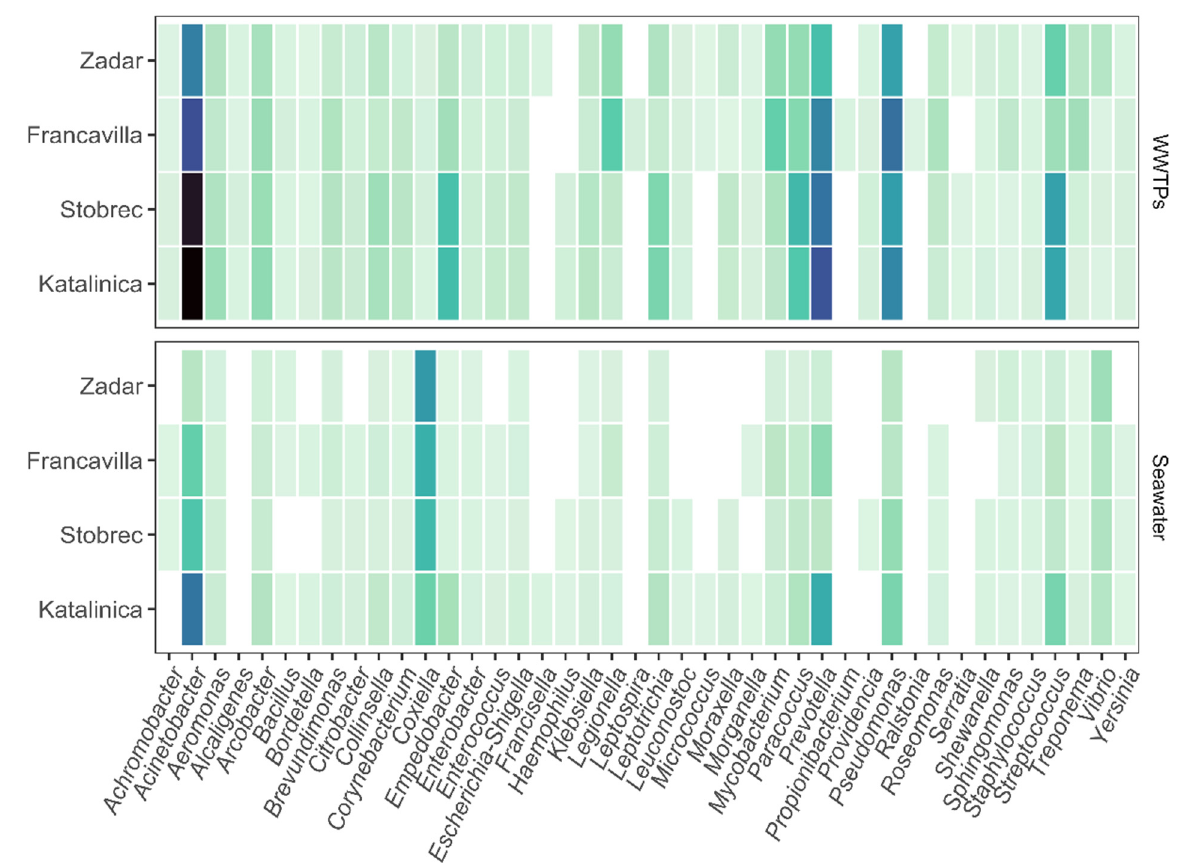
Figure 4. Potentially pathogenic bacteria in treated sewage (WWTPs) and seawater samples. Out of the 60 genera investigated Bacteriodes , Borrelia , Brucella , Burkolderia , Campylobacter , Chlamydia , Enterobacter , Laclercia . Listeria , Orientia , Rosemonas , and Salmonella were not found in the dataset. ASV raw counts are log(1 + x) transformed to improve visualization and comparisons between samples. Tiles represent the average count over time per site. Higher values correspond to darker colors. White tiles indicate 0 reads.